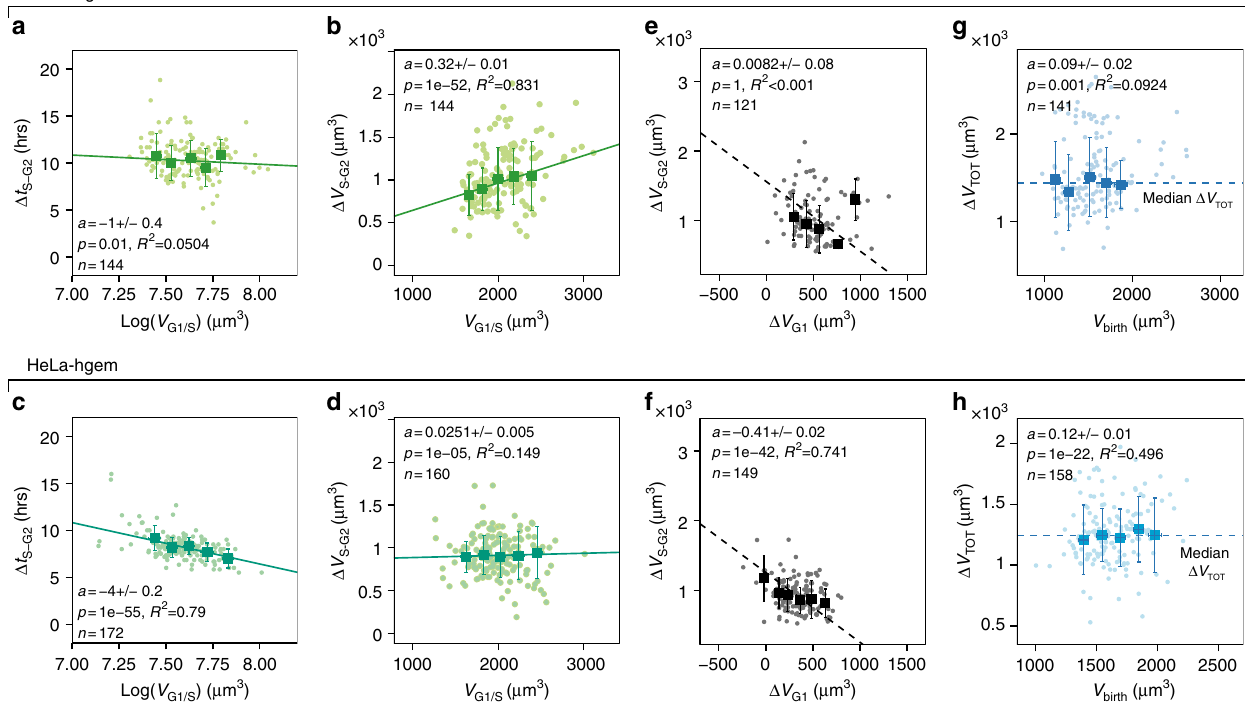
Fig. 5 S-G2 duration is negatively correlated with volume at G1/S in HeLa but not HT29 cell. a Duration of S-G2 phase, Δ t S − G 2 vs. the logarithm of volume at G1/S transition ( V G1/S ) for HT29-hgem ( N = 4). b Added volume in S-G2 phase, Δ V S − G 2 vs. volume at G1/S transition ( V G1/S ) for HT29-hgem ( N = 4). c Duration of S-G2 phase, Δ t S − G 2 vs. the logarithm of volume at G1/S transition ( V G − S ) for HeLa-hgem ( N = 2). d Added volume in S-G2 phase, Δ V S − G 2 vs. volume at G1/S transition ( V G1/S ) for HeLa-hgem ( N = 2). e , f Added volume in S-G2, Δ V S − G 2 vs. added volume in G1 ( V G1 ) for HT29-hgem ( N = 4) ( e ) and HeLa-hgem ( N = 2) ( f ). Dashed black line represents the slope expected in the case of a mechanistic adder where: Δ V S − G 2 = 〈 Δ V TOT 〉 − Δ V G 1 (slope of − 1). g , h Added volume in the whole cell cycle Δ V TOT vs. volume at birth (V birth ) for HT29-hgem ( N = 4) ( g ) and HeLa-hgem ( N = 2) ( f ). For all the plots in this fi gure, individual cell measures (dots) and median bins (squares) ± s.d. (bars) are shown. Solid line is a linear regression on the median bins weighted by the number of observations in each bin. See also Supplementary Figure cells (Fig. 6d for G1, Supplementary Fig. 7d, e for S-G2 and complete cell cycle, and Supplementary Fig. 7f relative to G1/S transition). Thus, the growth modulation that leads to size control linear mode of growth.